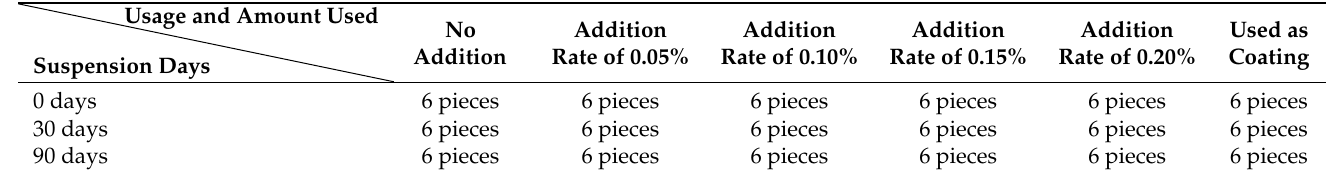
Table 1. Experimental setup of concrete specimens for the test block group.